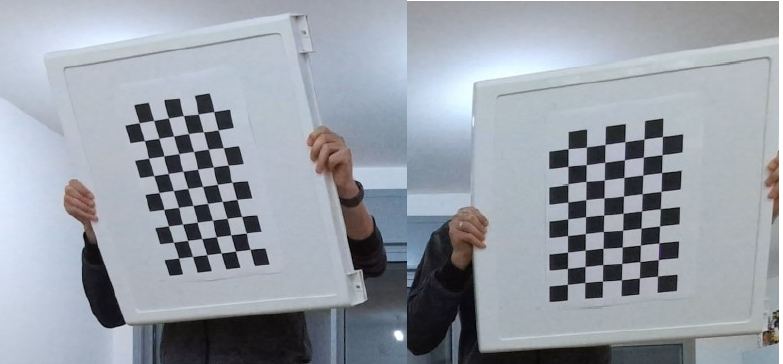
Figure 2. Checkerboard calibration: two corresponding frames from two synchronized camera